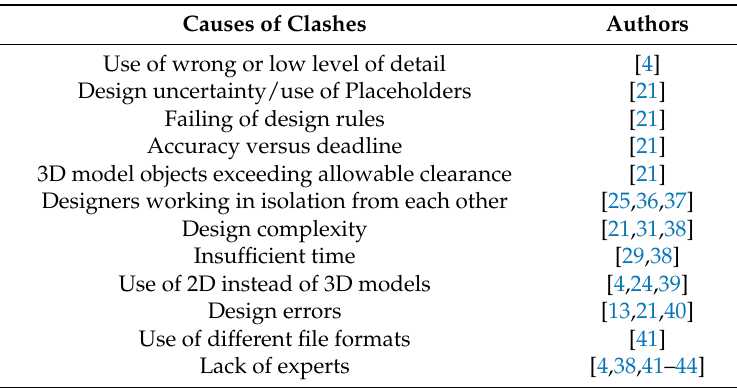
Table 1. Summary of the causes of hard/soft